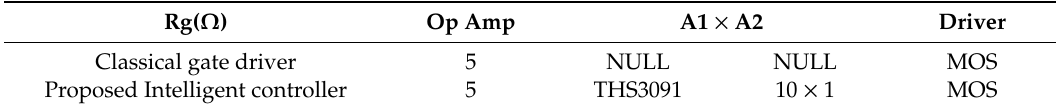
Table 1. Experiment circuit